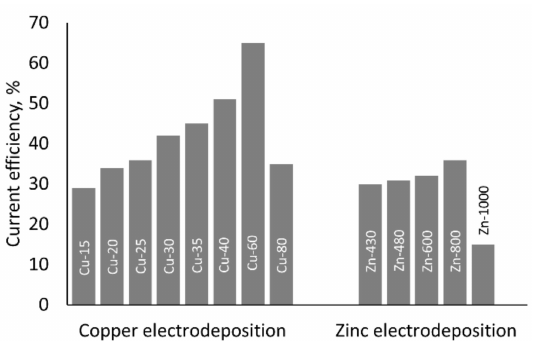
Figure 11. The effect of metal acetate (CuAc or ZnAc) concentration on current efficiency of copper and zinc electrodeposition at 100 ◦ C, conducted at j c = 3 mA · cm 2